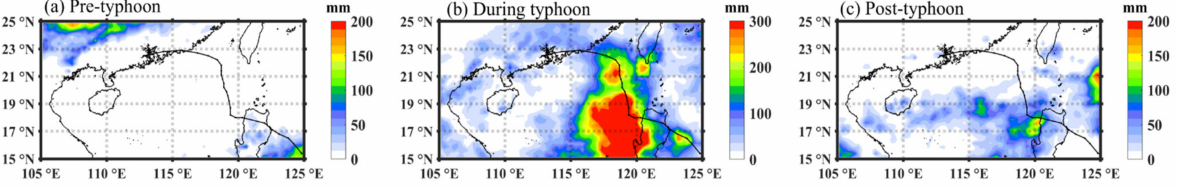
Figure 9. Spatial distribution of cumulative rainfall during pre-typhoon ( a ) 1–4 July, during typhoon ( b ) 5–9 July, and post-typhoon ( c ) 10–13 July. The black line denotes typhoon